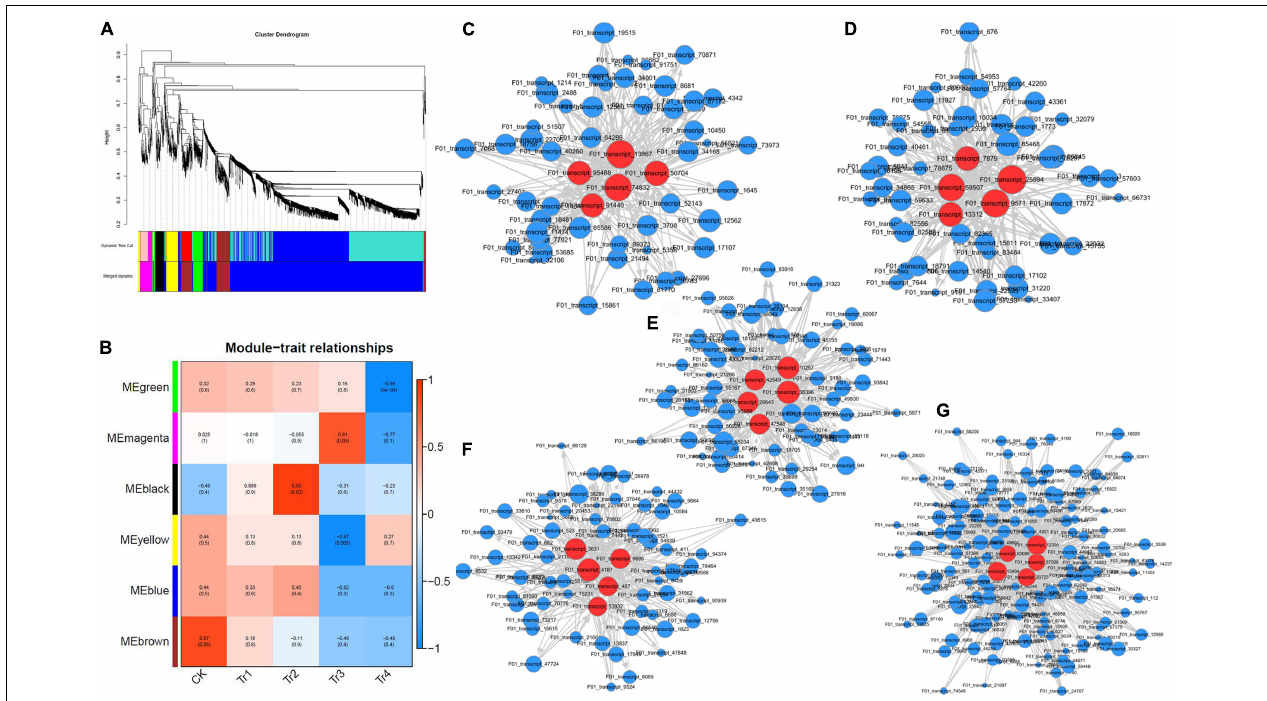
FIGURE 3 | WGCNA characteristics of differently expressed transcripts in K. virginica seedlings under saline–alkali stress. (A) Clustering dendrograms of genes and detected modules. (B) Heatmap of the correlation between modules and traits. (C–G) Gene co-expression networks of Meblack, Mebrown, Megreen, Memagenta, and Meyellow. Red dots represent core